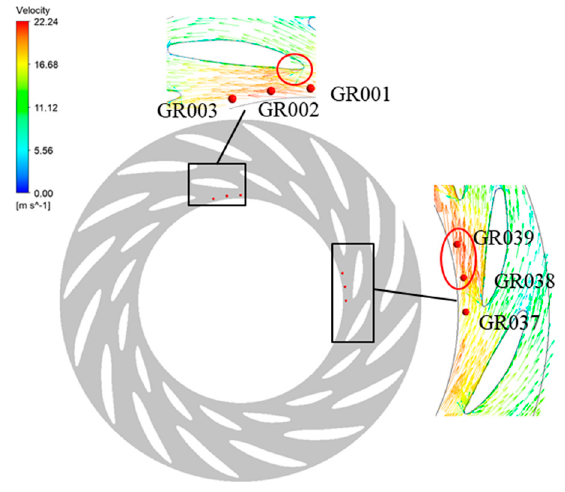
Figure 16. Velocity distribution around the monitoring points at 1.0 Q d .